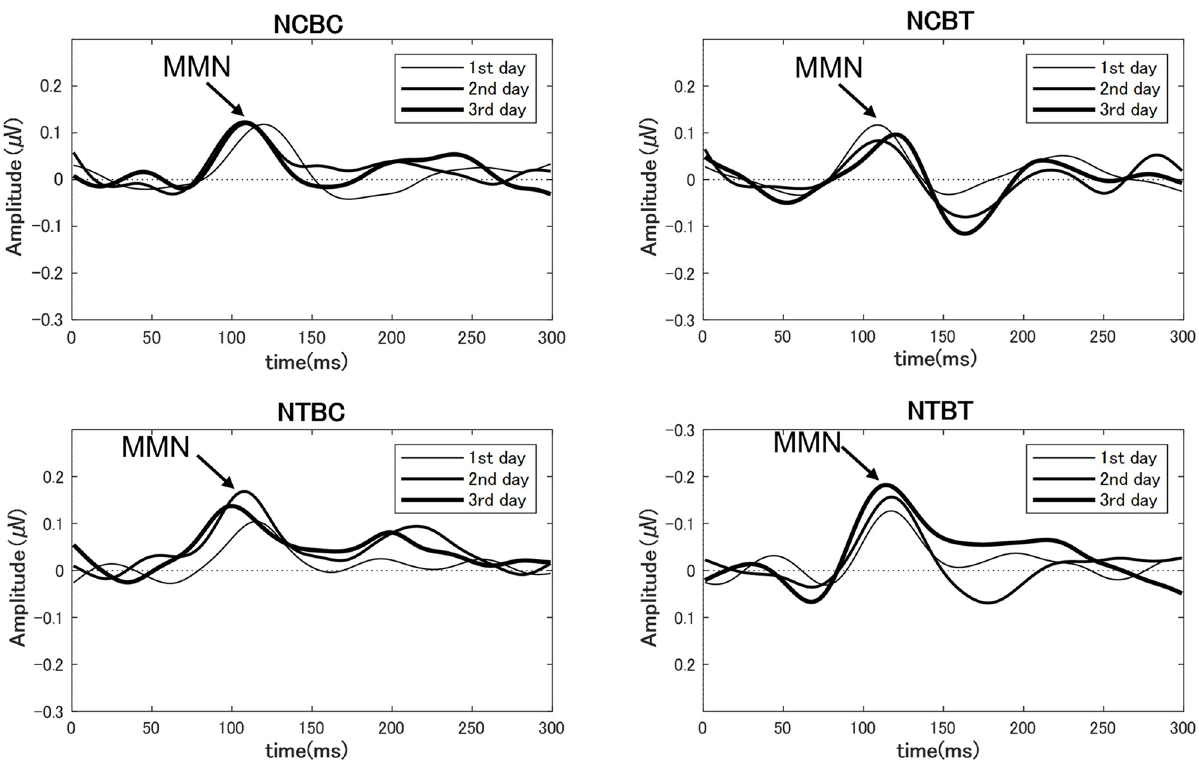
Fig 7. The group grand average MMN responses on each training day in four groups